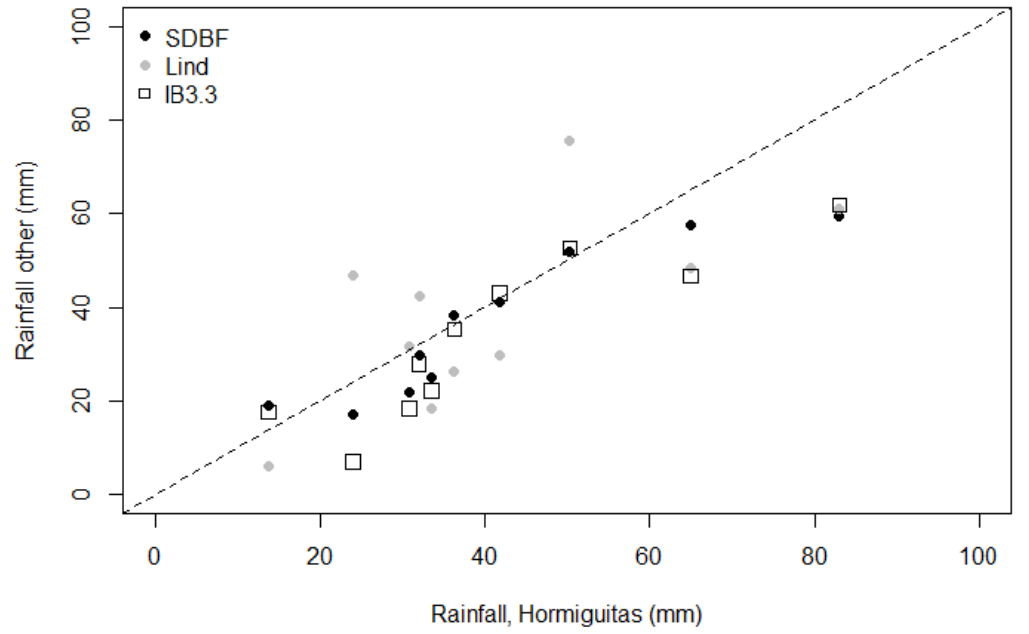
Figure 5. Event-total precipitation at the Hormiguitas rain gauge (RG.HM) versus three other nearby stations (see Figure 1). The dashed line is the 1:1 line. Taken from Biggs et al. [33].